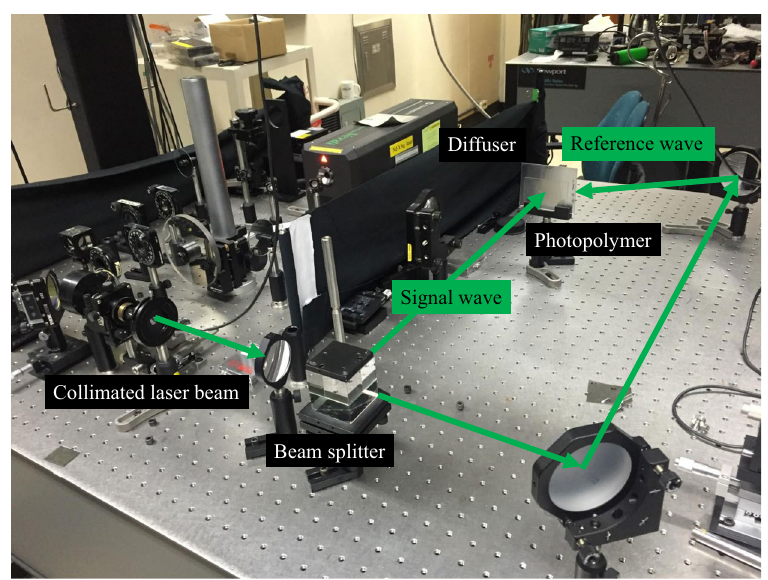
Figure 8. Recording experimental setup of